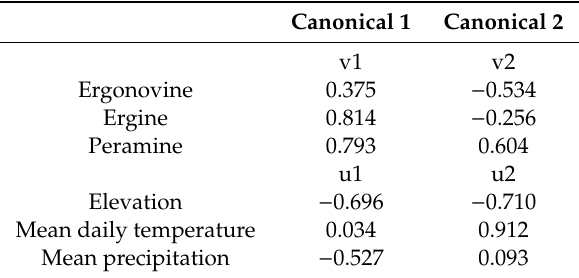
Table 5. Correlation coefficients between the original variables and their canonical variates (canonical